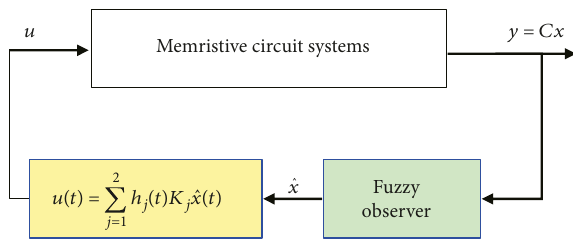
Figure 2: Observer-based fuzzy control structure